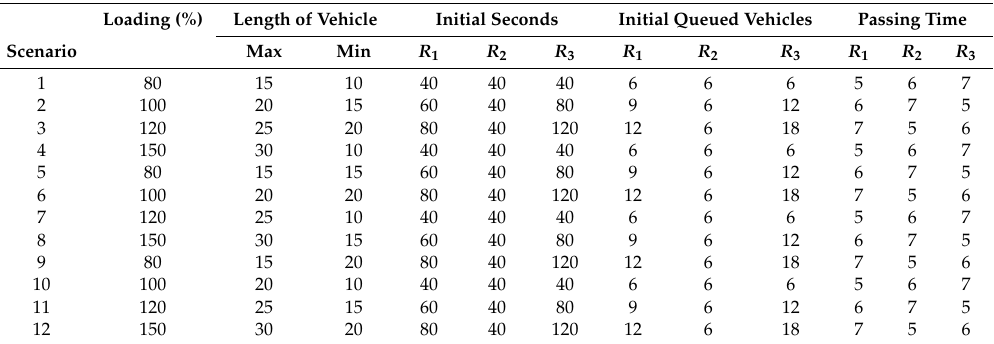
Table 1. The design of the test problems.